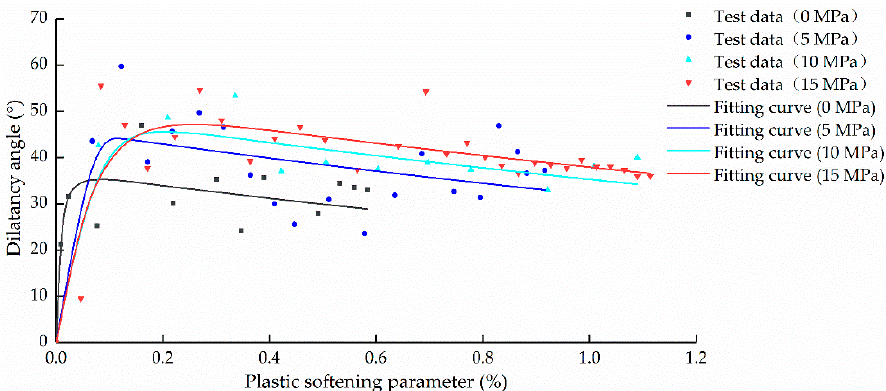
Figure 7. The fitting curve of the dilatancy angle.